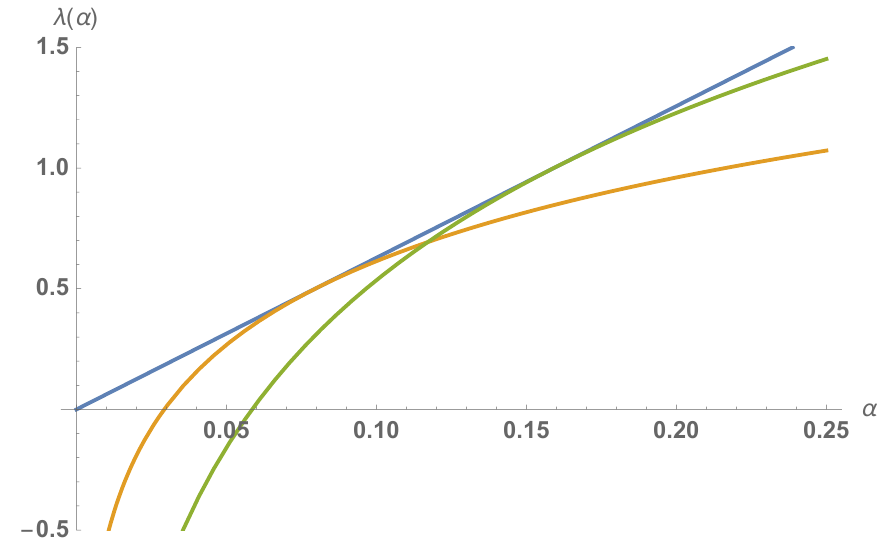
Figure 4 . Sparseness condition 2 πα (blue line) vs. density of states of averaged chiral theory, λ ch ( α ) (orange) and λ C ( α )